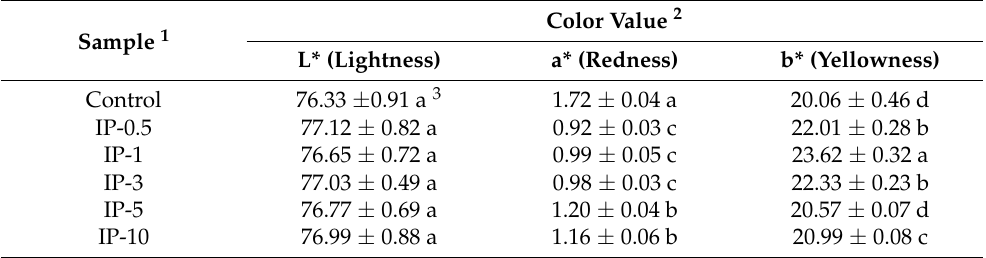
Table 2. Hunter’s color values of soybean sprouts grown after different concentrations of illite treatment.